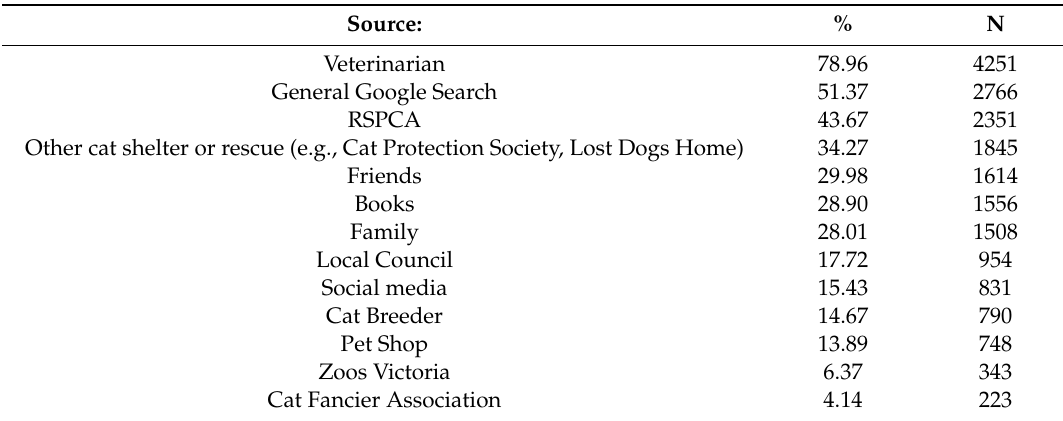
Table 4. The percentage of cat owners in this sample who go to or would go to the various listed sources for cat care and management advice. Participants were able to select multiple